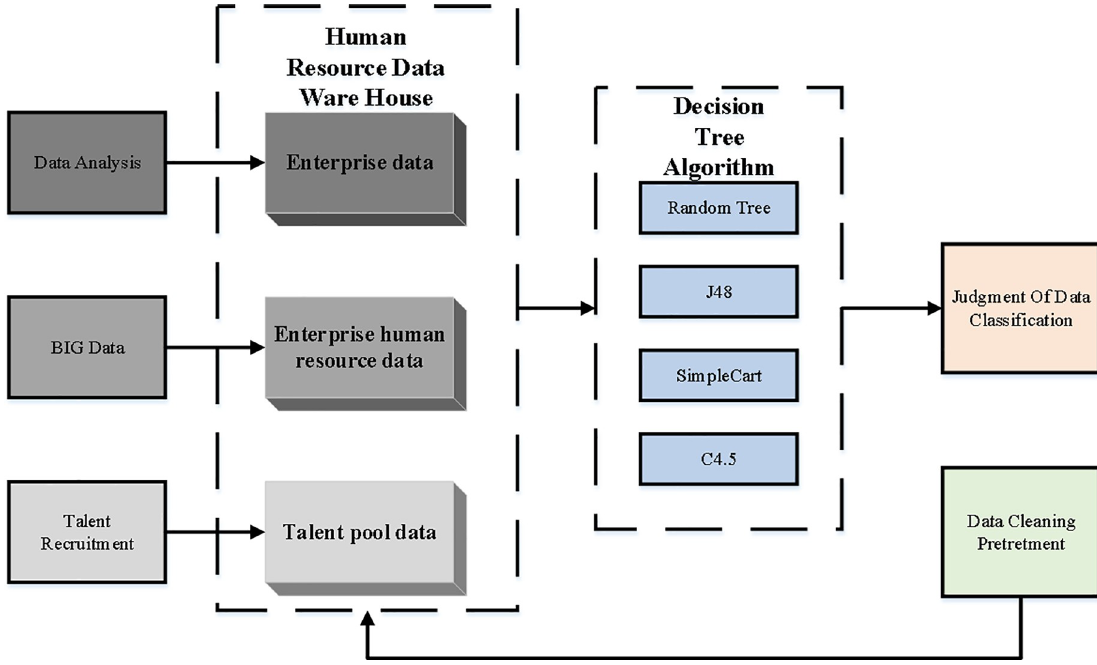
Fig 2. System composition of ensemble classifier based on data mining in HRM system.